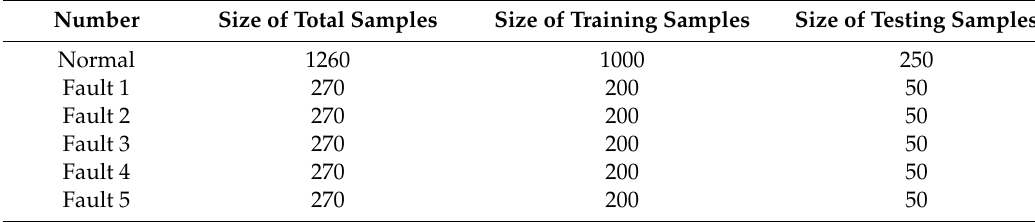
Table 3. Sample description of the di ff erent sensor